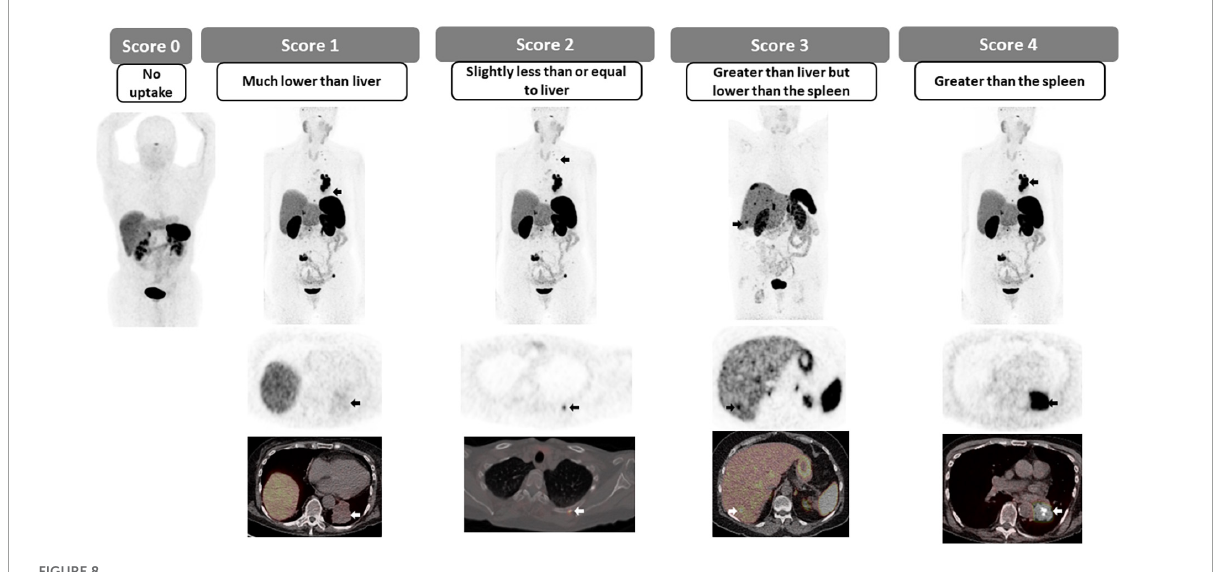
FIGURE8 Krenning scoring system.